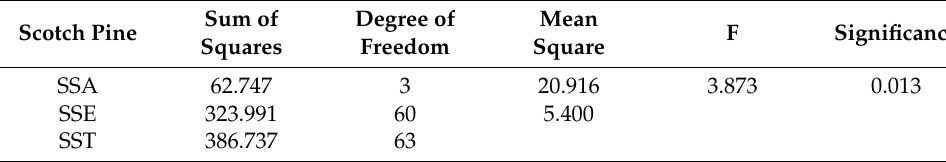
Table 3. ANOVA of scotch pine for temperature. Scotch Pine